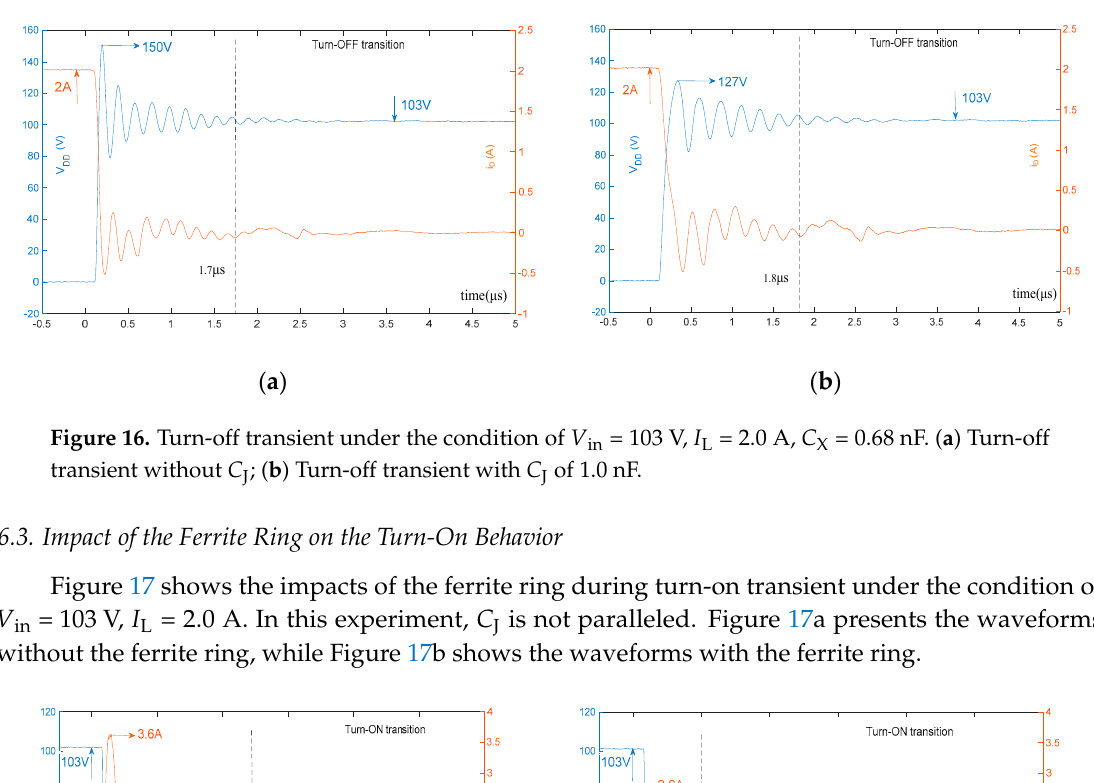
Figure 16. Turn-off transient under the condition of V in = 103 V, I L = 2.0 A, C X = 0.68 nF. ( a ) Turn-off transient without C J ; ( b ) Turn-off transient with C J of 1.0 nF.